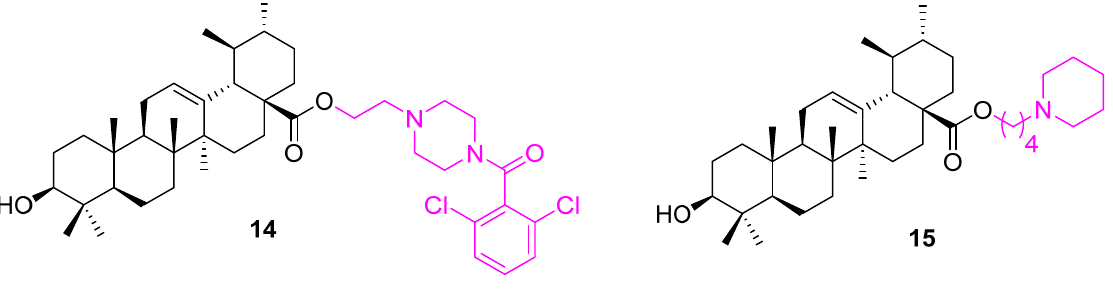
Figure 10. Structure of 14 , 15 .